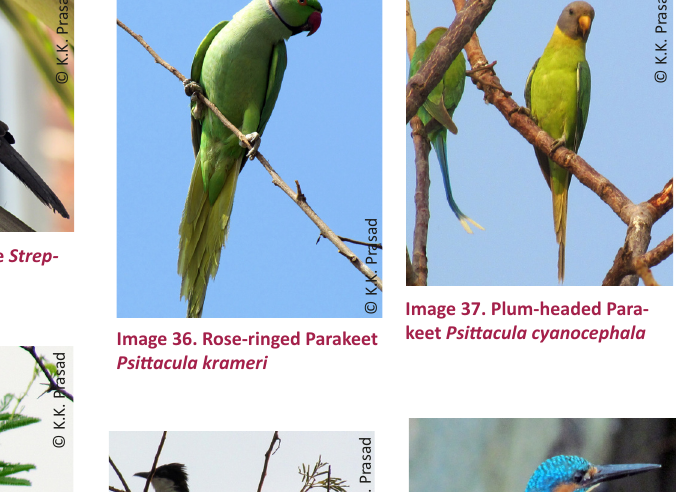
Image 38. Small Green-billed Malkoha Phaenicophaeus viridirostris